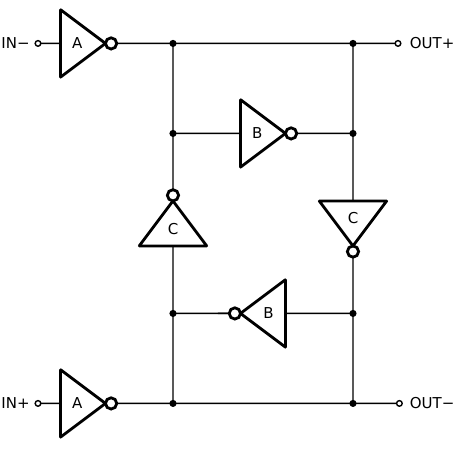
Figure 6. Nauta (N) OTA circuit diagram